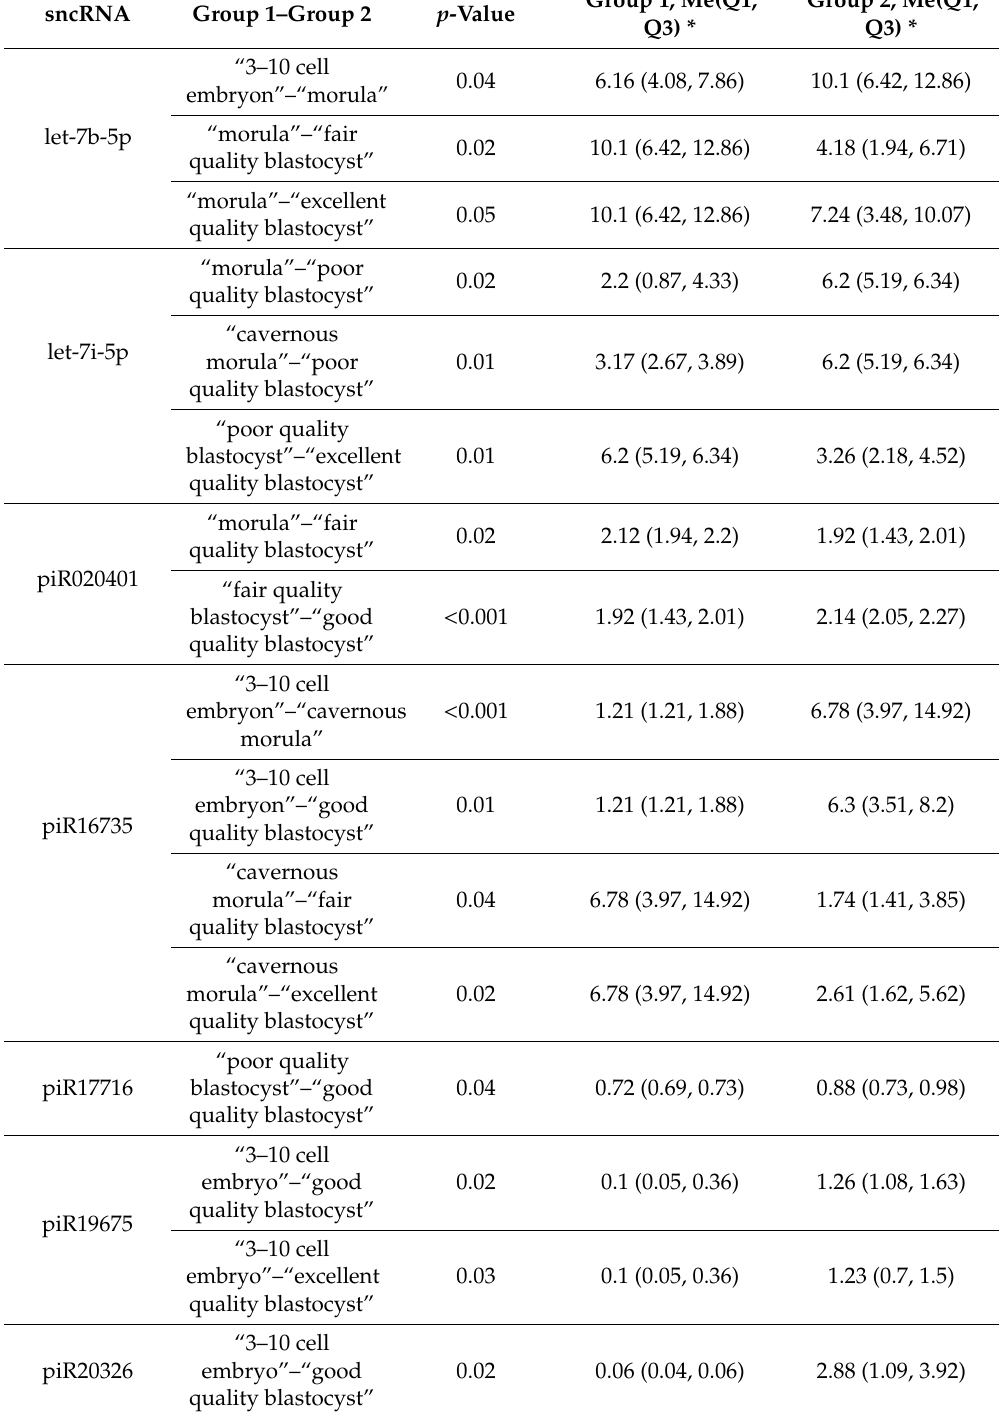
Table 2. Pairwise comparison of the fold changes in the expression level of sncRNAs in the sample groups shown in Figure